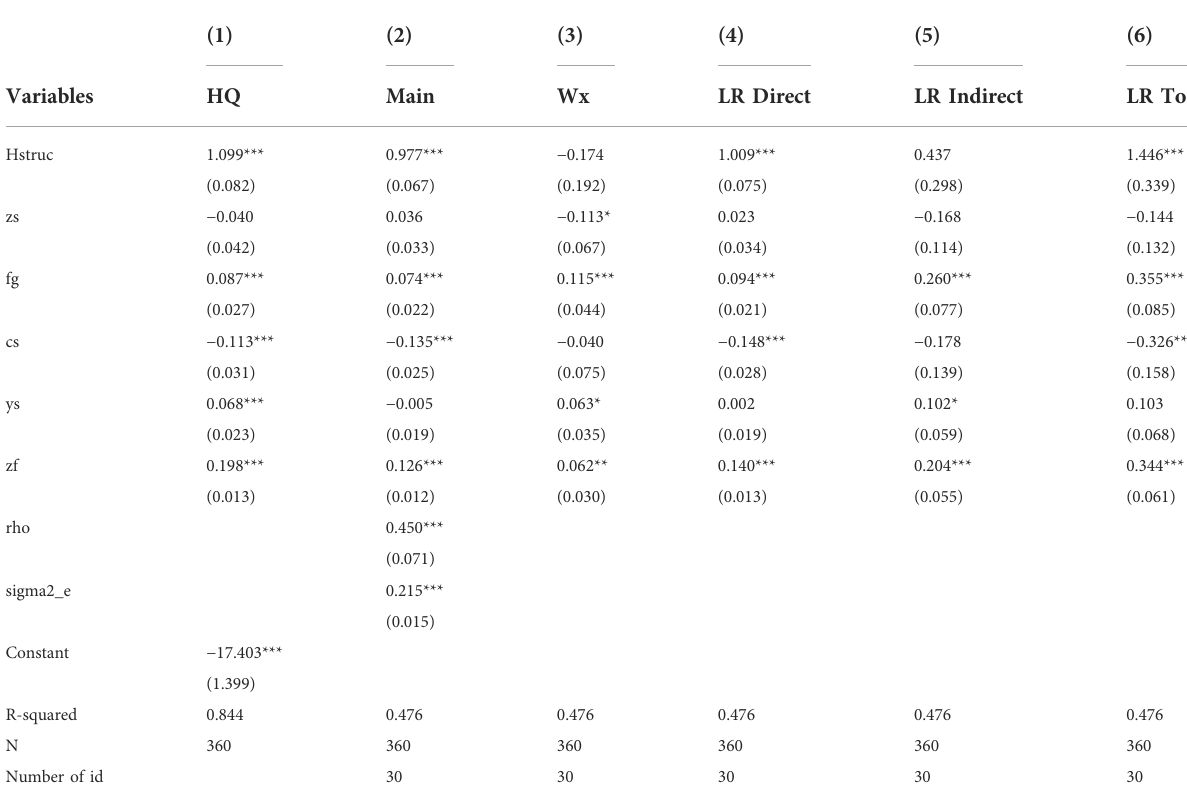
TABLE 13 Robustness